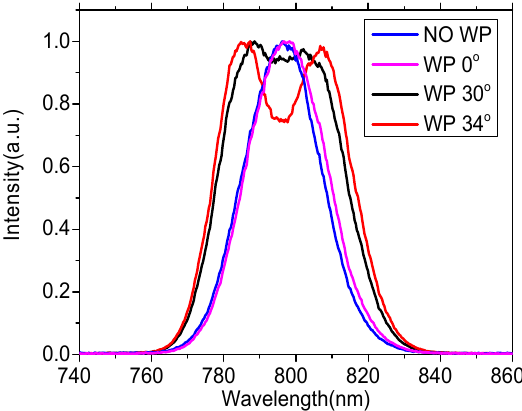
Figure 6. The spectra of the amplified beam for different rotation angles of the WP.